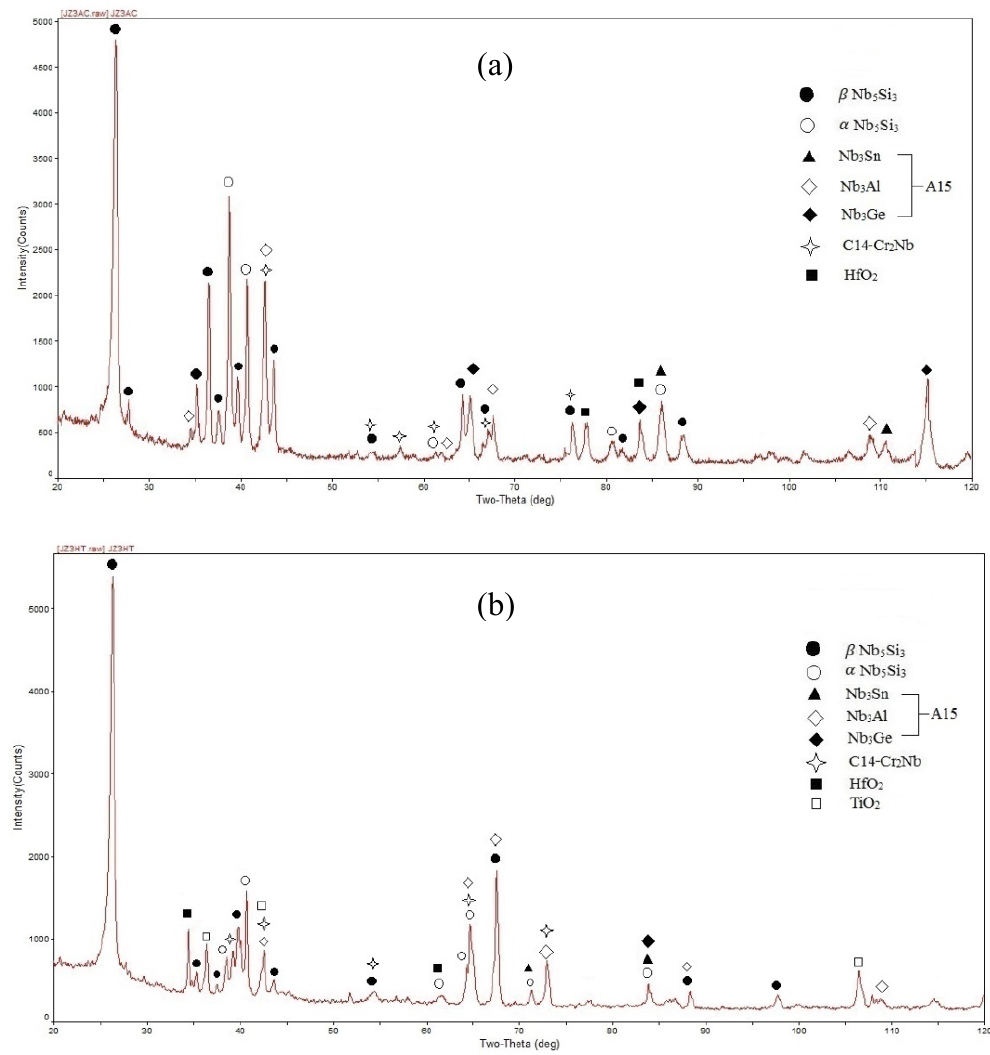
Figure 1. The X-ray diffractograms of the alloy JZ3. ( a ) AC and ( b ) HT.